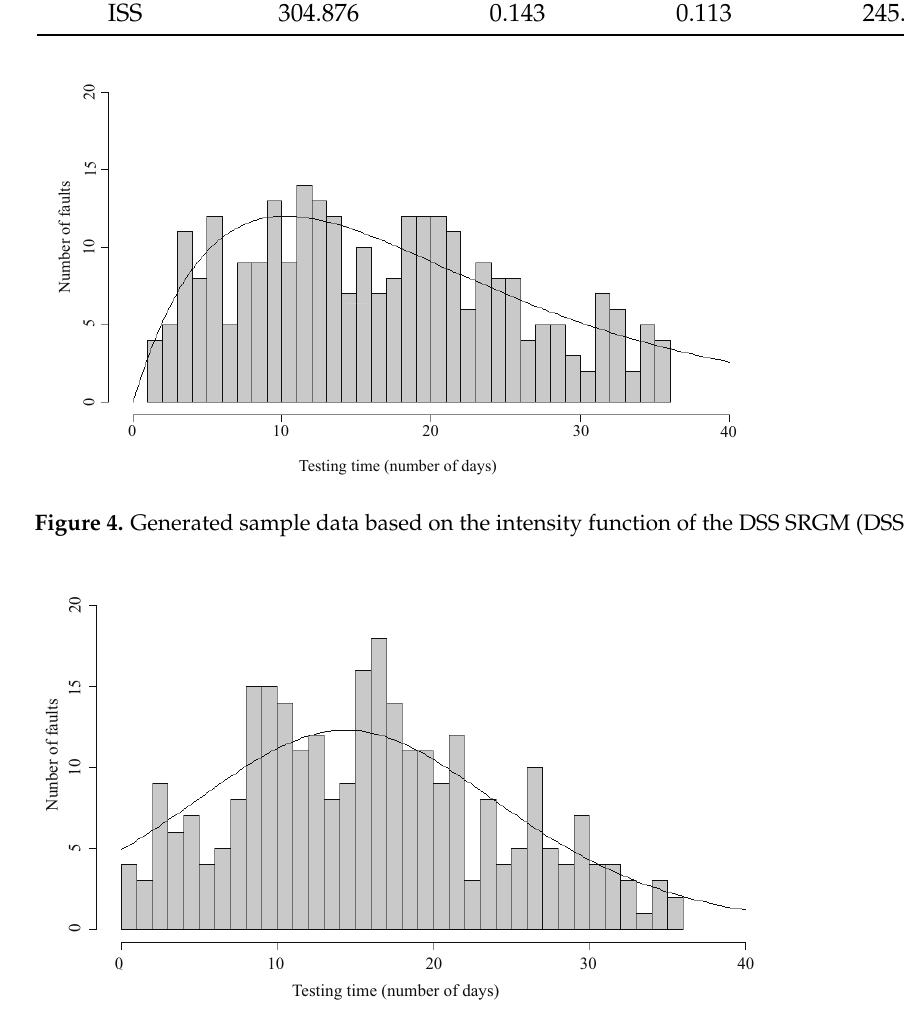
Figure 5. Generated sample data based on the intensity function of the ISS SRGM (ISS